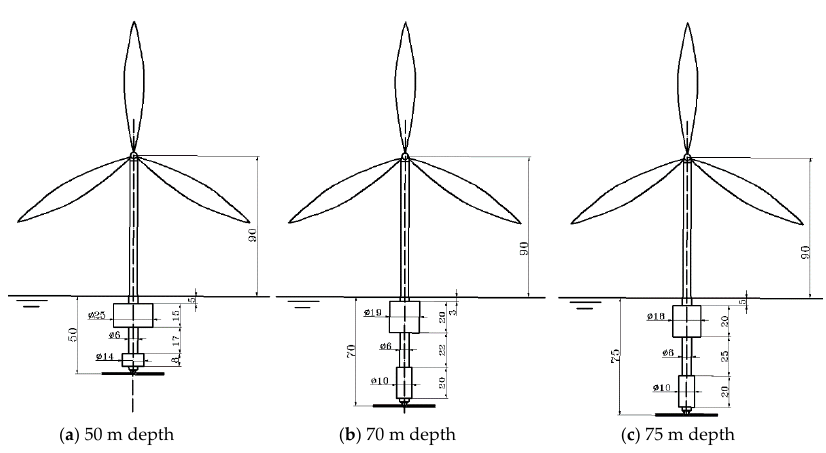
Figure 2. Articulated offshore wind turbine. Table 2. Main design parameters of the articulated offshore wind turbine (AOWT).